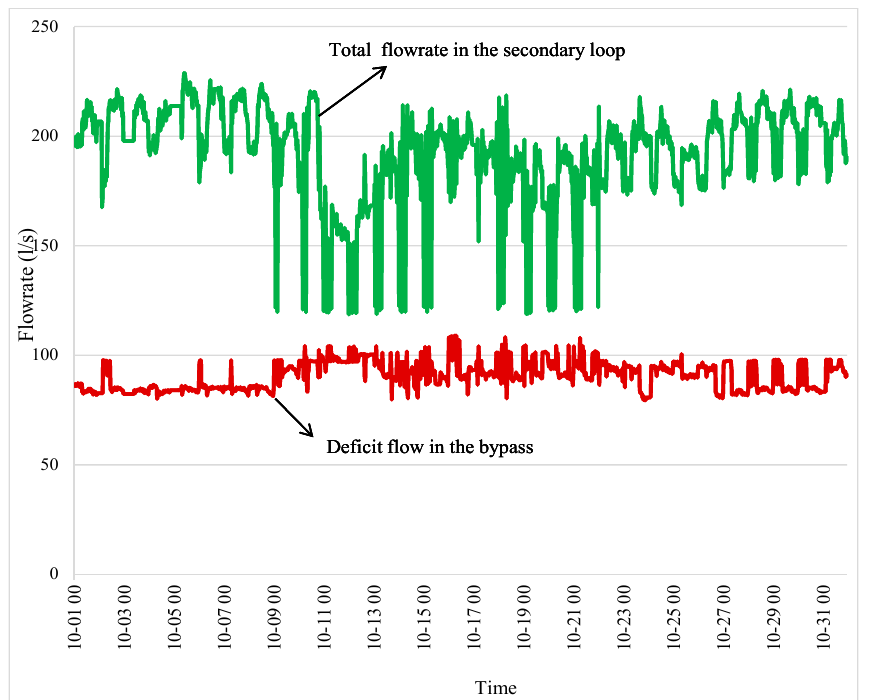
Figure 7. Actual supply temperature of the chilled water system.